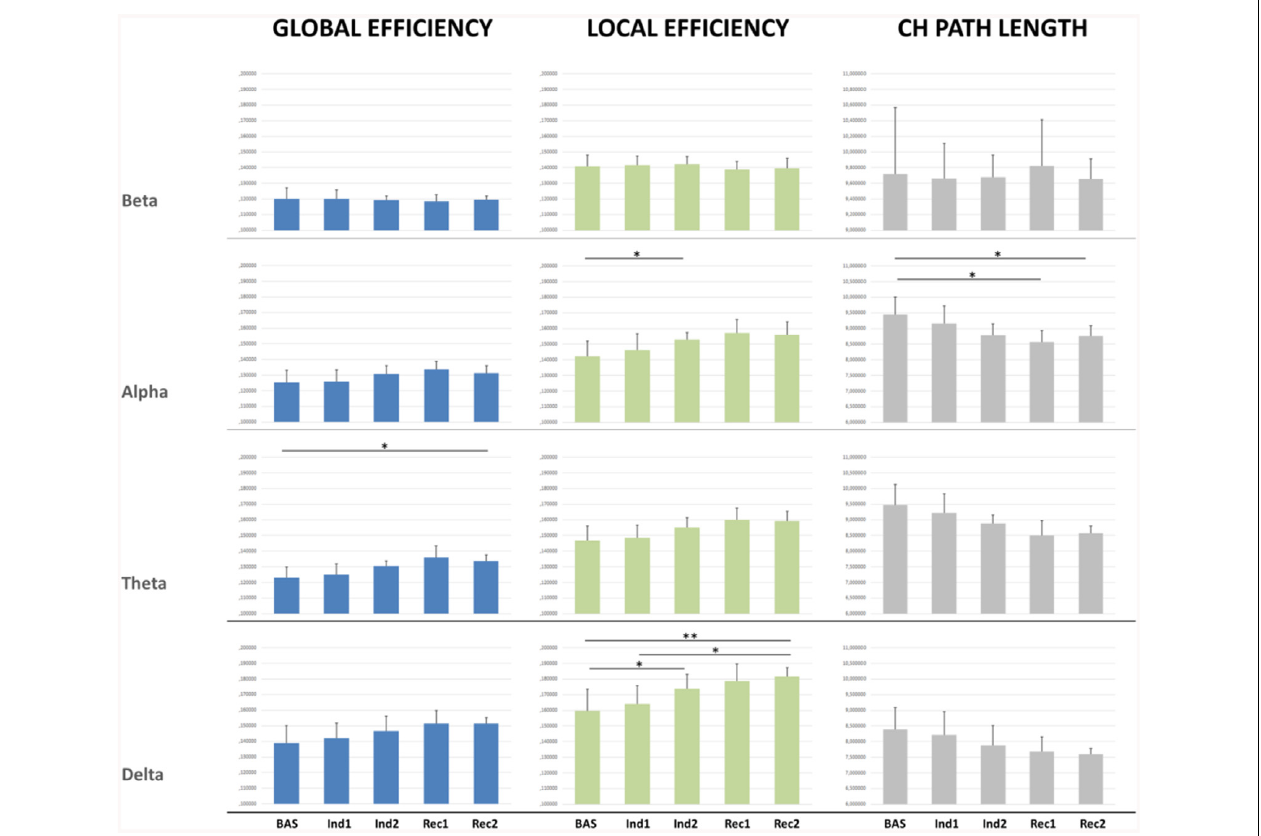
FIGURE 3 | Connectivity indexes measured for the whole brain network for each EEG band in each condition. ∗ p < 0.05; ∗∗ p <